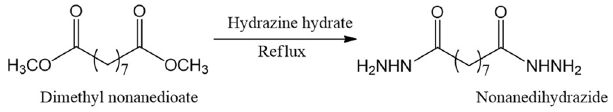
Figure 1. Schematic route for the synthesis of